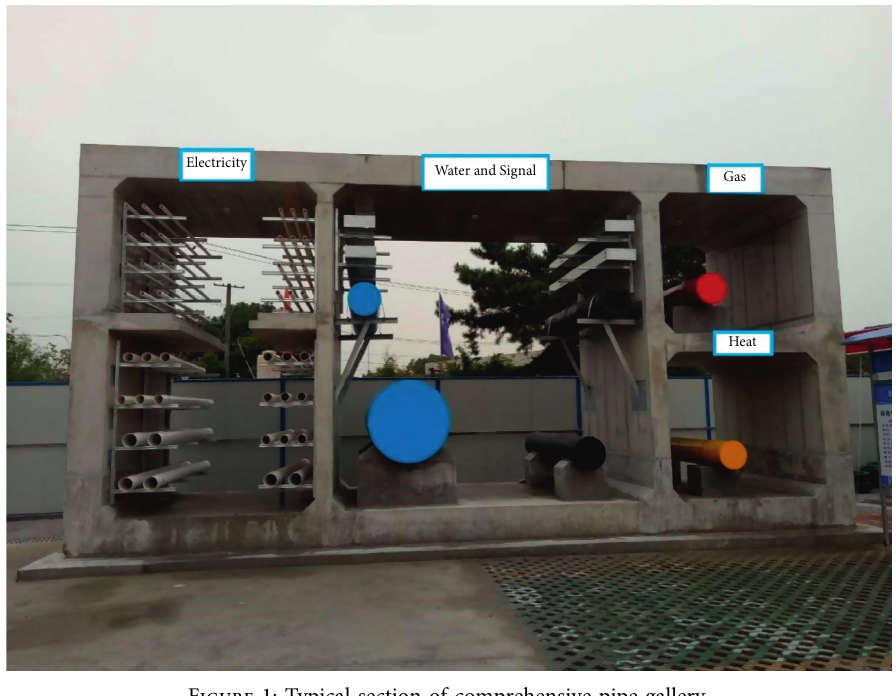
Figure 1: Typical section of comprehensive pipe gallery.